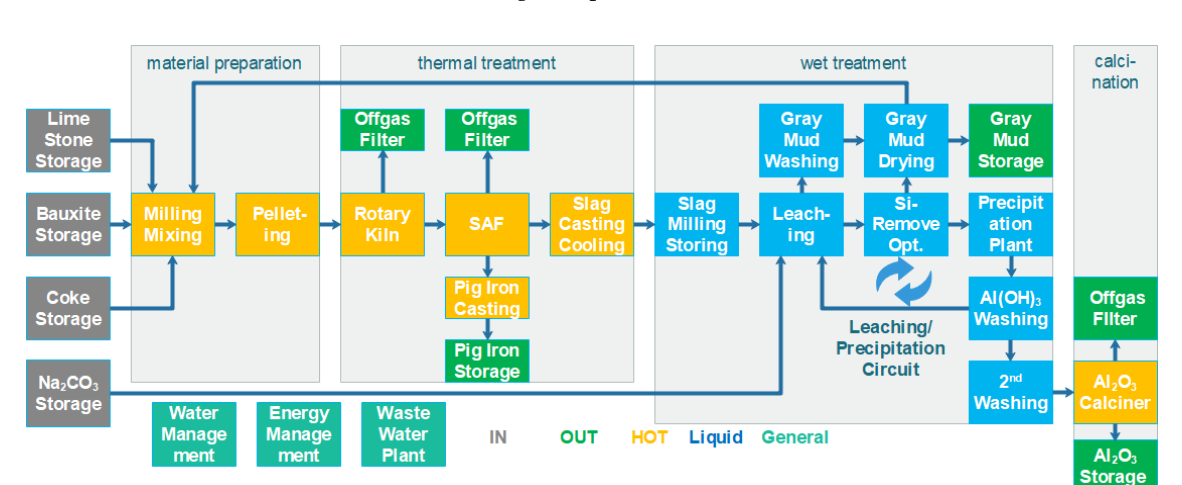
Table 1. Chemical composition of main input